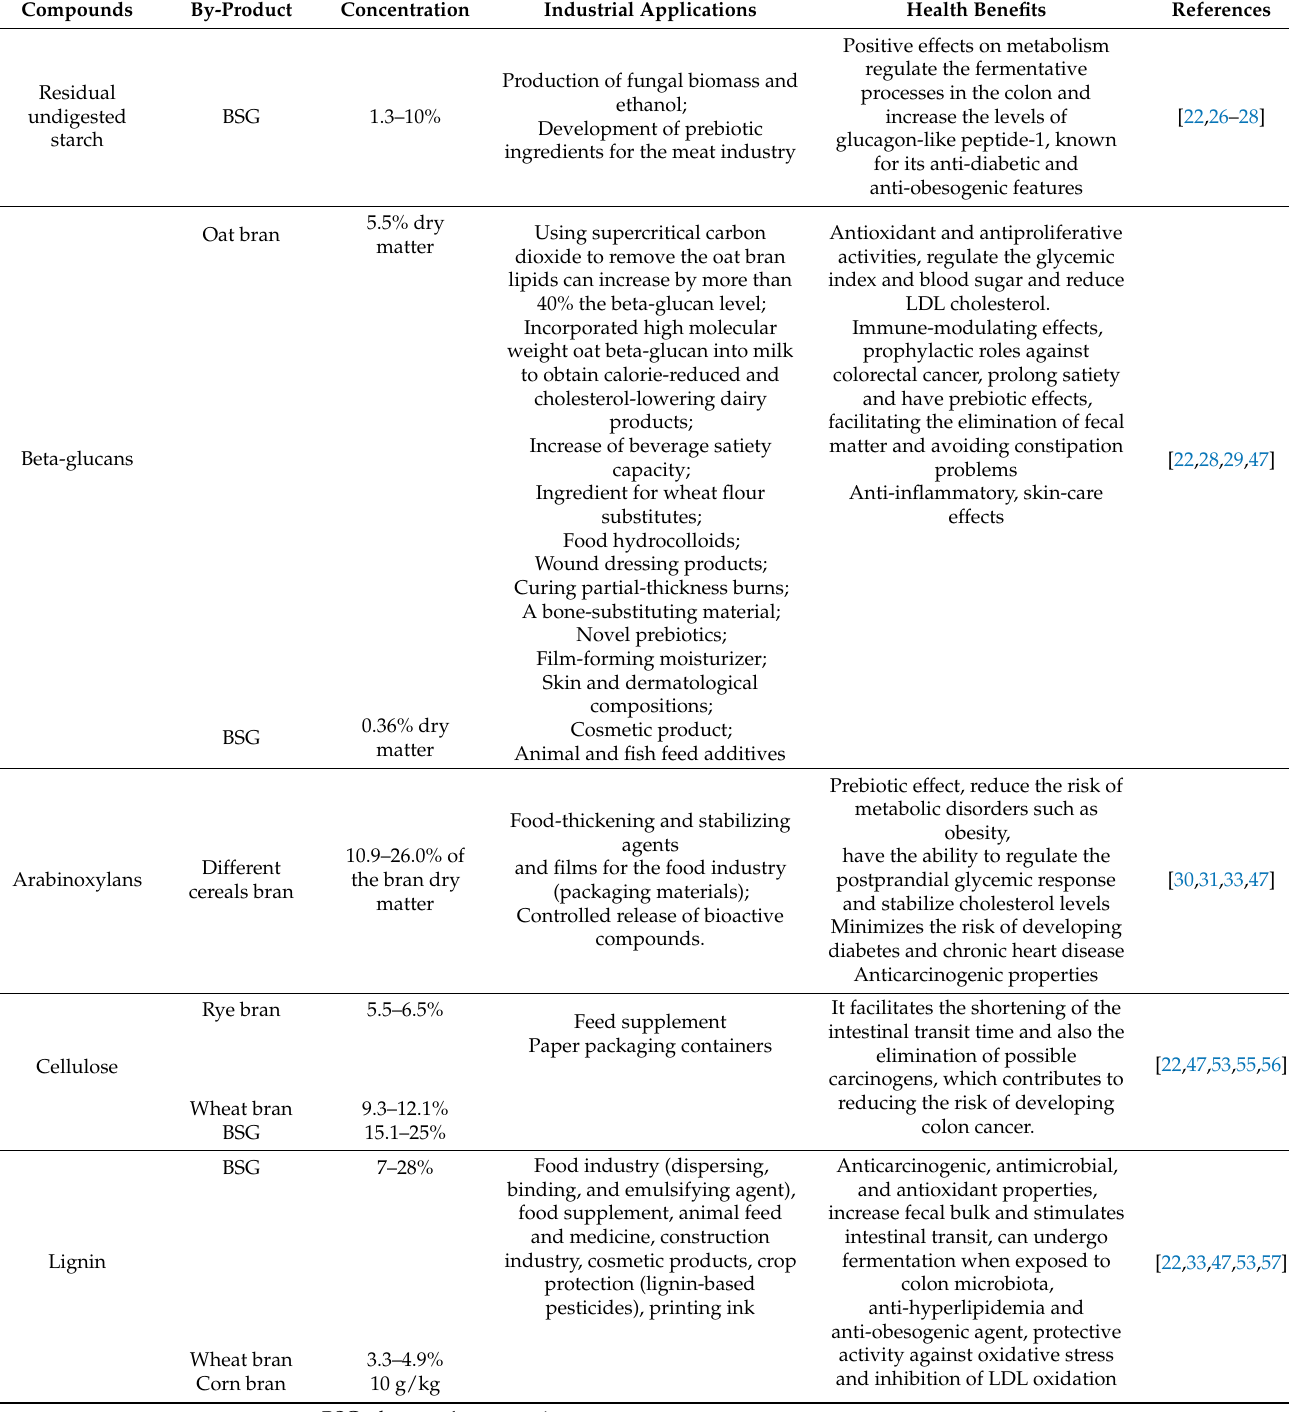
Table 1. Themaincarbohydratescompositionofdifferentgrainby-productsandtheirpotentialapplication.